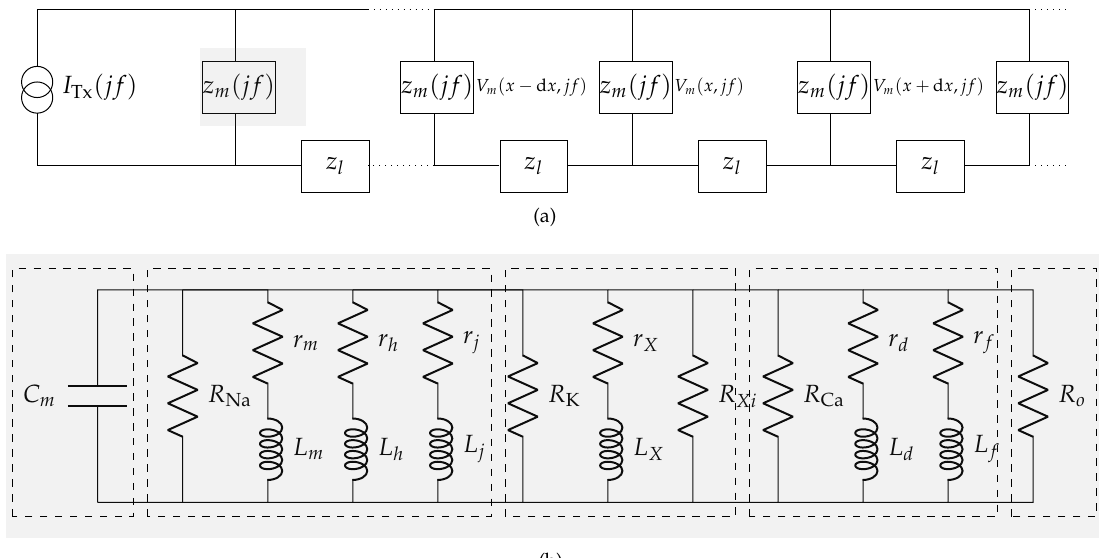
Figure 3. Communication channel in the subthreshold cardiac communication system. ( a ) The general representation of the subthreshold cardiac communication channel as a one-dimensional cable. ( b ) The linearized membrane circuit corresponding to the shaded block in Figure 3a. (1)-segment consists of the capacitor derived from the bilayer membrane; (2)-segment consists of passive components derived from the voltage-gated sodium channels; (3)-segment consists of passive components derived from the voltage-gated potassium channels; (4)-segment consists of passive components derived from the voltage-gated slow inward current which mainly contains calcium channels; (5)-segment consists of the resistor derived from the plateau potassium current and background